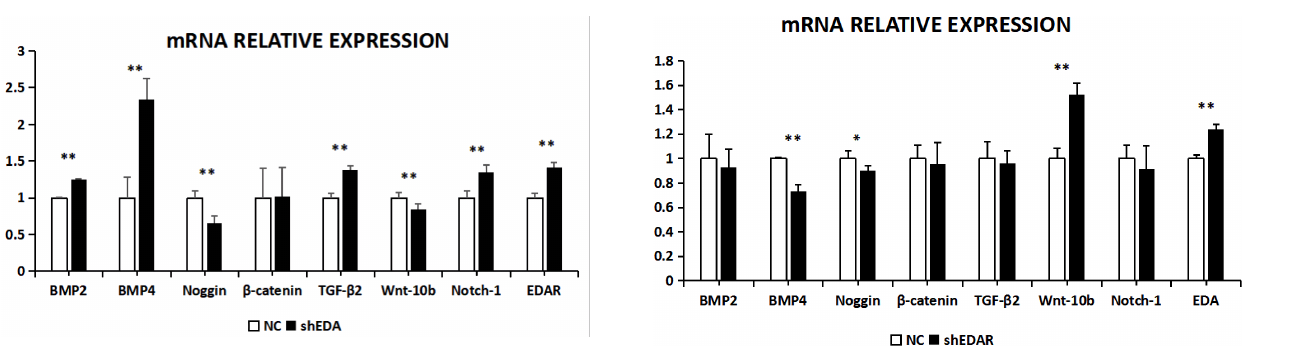
Figure 8. The mRNA relative expression of BMP2, BMP4, noggin, β -catenin, TGF- β 2, Wnt-10b, NOTCH1, and EDA after EDAR in- terference. Note: ∗ significant difference. ∗∗ Extremely significant